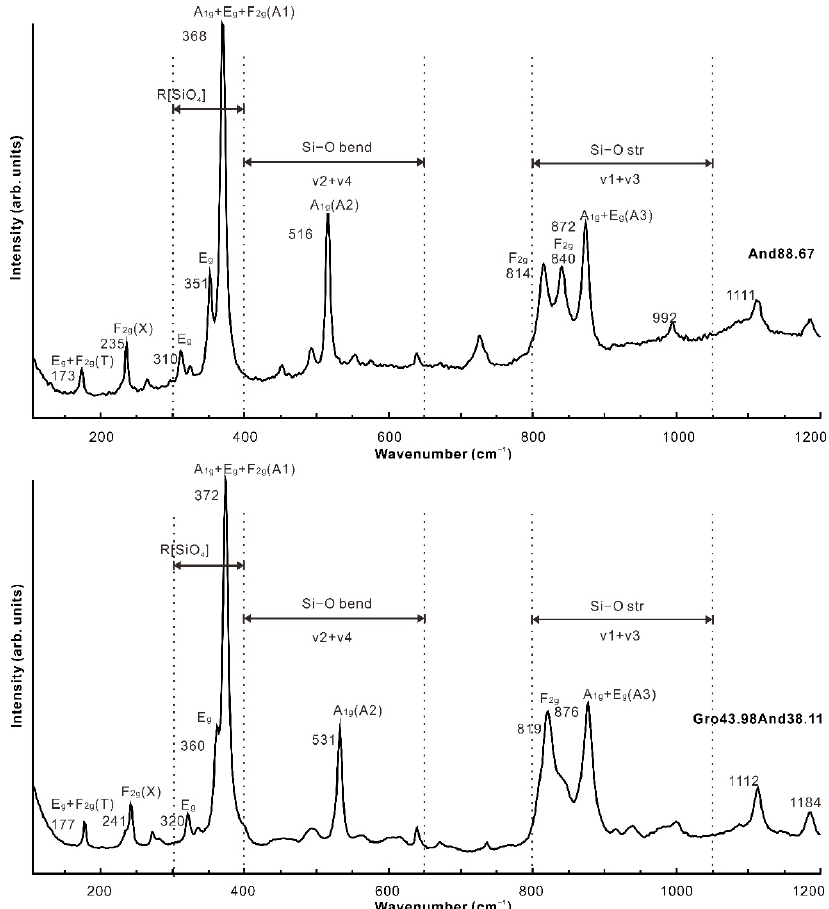
Figure 3. Two typical Raman spectra of the garnets from Jiama. The A 1g , E g , and F 2g means the Raman peak is visible in the modes. Many vibration bands of the E g and F 2g modes are not visible. T, X, A1, A2, and A3 refer to a specific Raman peak, where T and X represent the translation of [SiO 4 ] tetrahedron and dodecahedral cations, respectively, A1, A2, and A3 represent the rotation vibration (R[SiO 4 ]), the Si − O bending vibration (Si − O bend) and the Si − O stretching vibration (Si − O str) of [SiO 4 ] tetrahedron, respectively. Table 2. Raman peaks (cm − 1 ) of garnets.